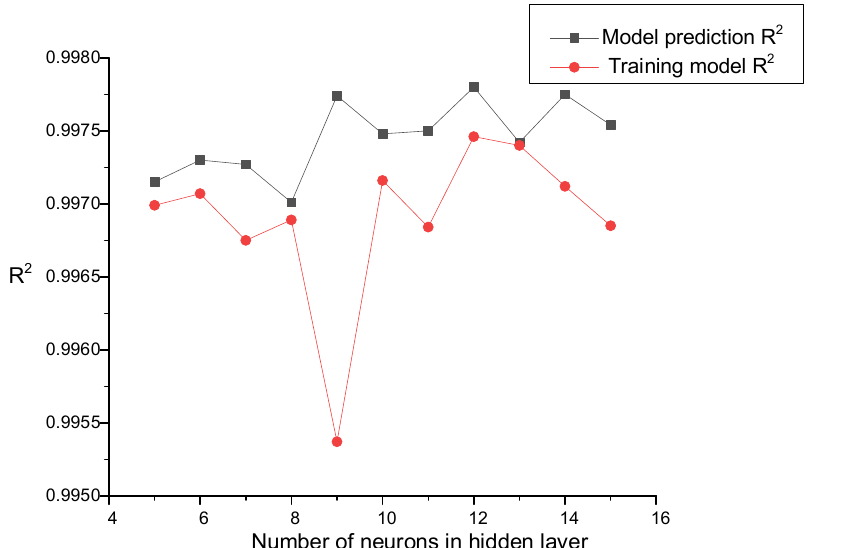
Figure 8. R 2 comparison of the model with 5–15 hidden neurons.